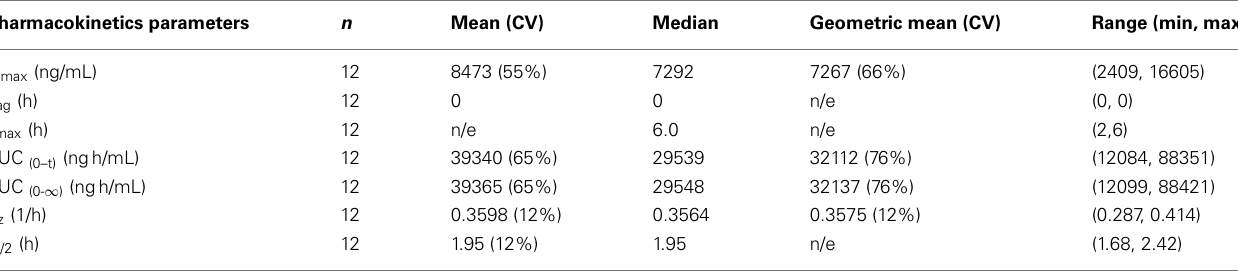
Table 4 | Summary of pharmacokinetic data after administration of 750mg dose of GSK1140115 in asthmatic subjects. Pharmacokinetics